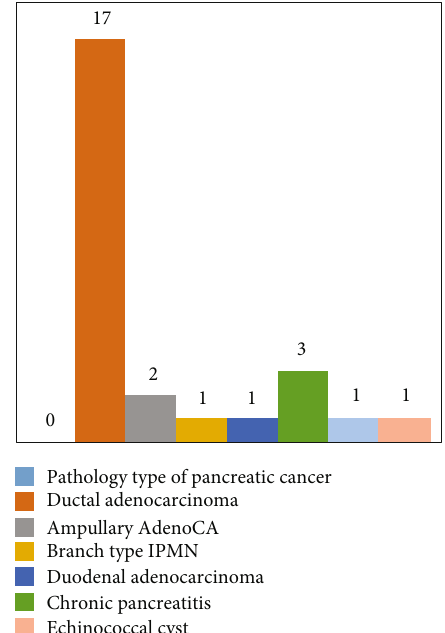
Figure 1: Pathologoanatomical studies of 26 PD. Table 1: The resected intestinal length in cm. The duodenum and jejunum are considered the main sites of motilin production. Conservation of the intestine as much as possible should result in more peristalsis and accelerated gastric